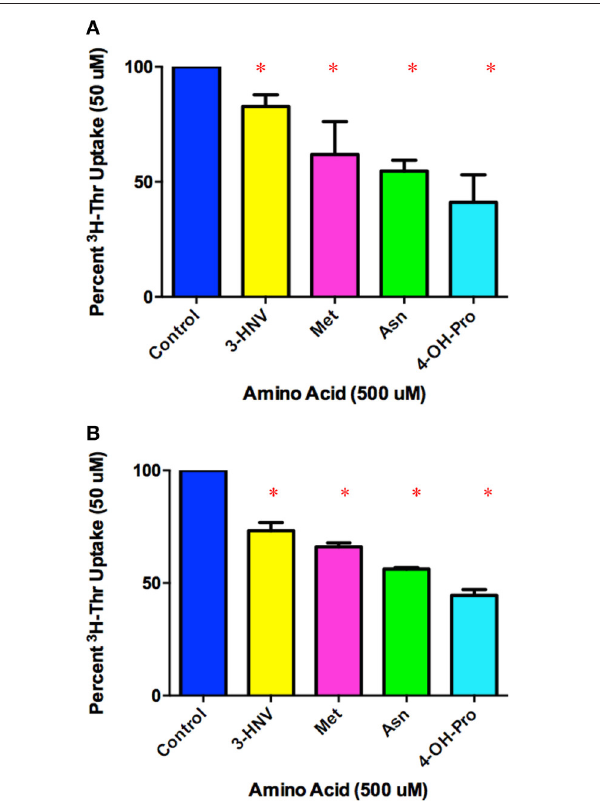
FIGURE 5 | Percent Na + -dependent uptake of 50 uM [ 3 H]-Thr remaining in the presence of the indicated amino acid (500 uM) (A) after subtraction of uptake in 140mM Choline Cl. A 1-sample t -test confirmed that all amino acids were statistically significant inhibitors ( * p < 0.05 ). A one-way ANOVA indicated no statistically significant difference in [ 3 H]-Thr uptake in the presence of the different amino acids tested ( p > 0.05 ) ( n = 4 for each column; 2 determinations obtained in each of 2 independent experiments). (B) Percent uptake of [ 3 H]-Thr remaining in the presence of the indicated amino acid (500 uM) but without subtraction of Na + -independent transport. A 1-sample t -test confirmed that all amino acids were statistically significant inhibitors ( * p < 0.05 ). A one-way ANOVA indicated 4-OH-Pro inhibited [ 3 H]-Thr uptake significantly more than the other amino acids tested ( p < 0.05 ). ( n = 4 for each column; 2 determinations obtained in each of 2 independent